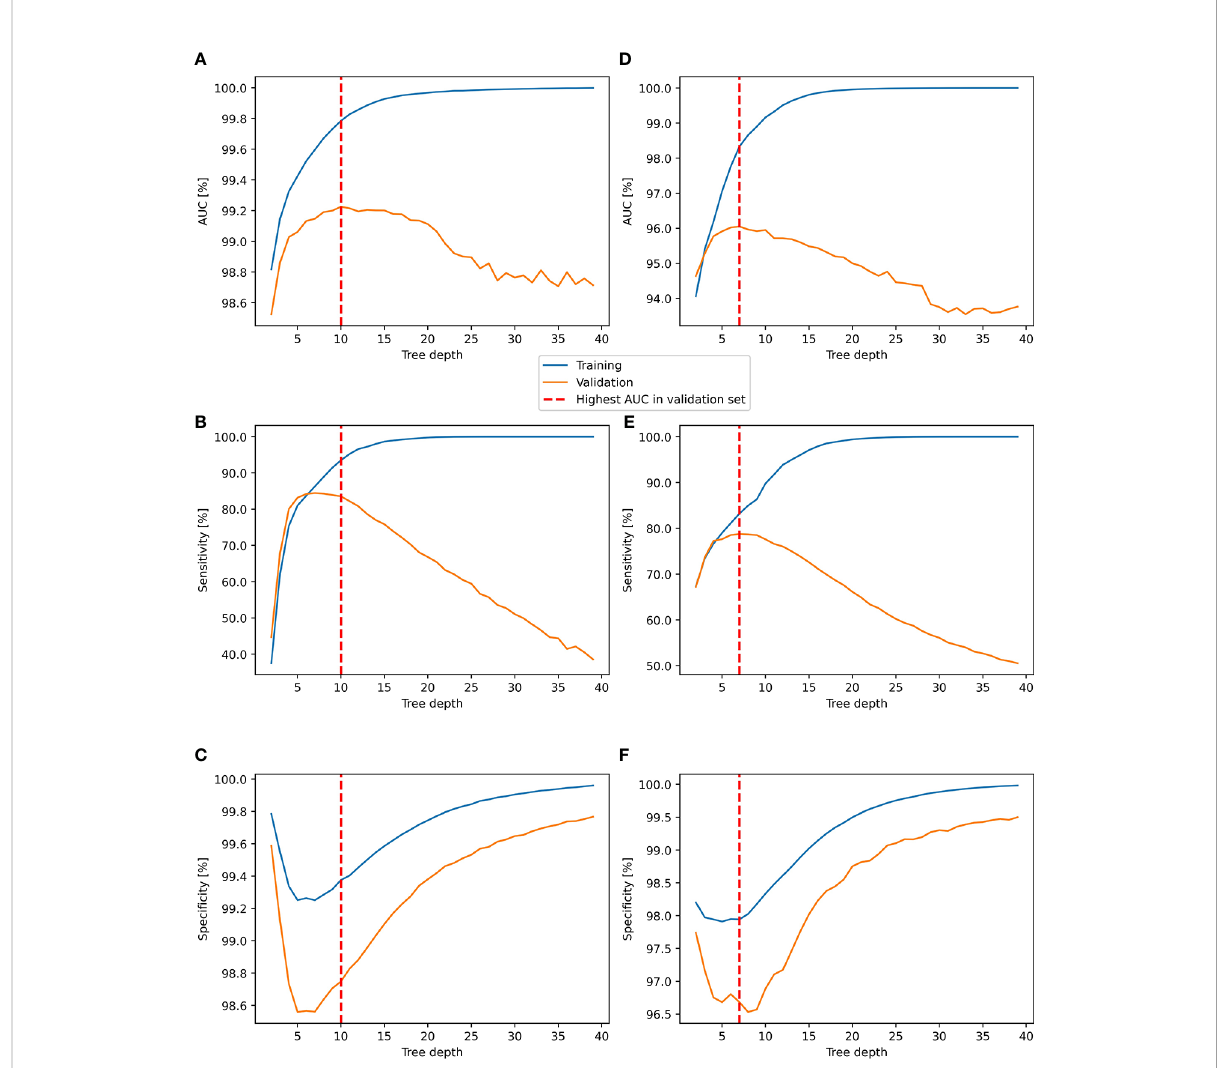
FIGURE 6 Performance of the RF classi fi er in the training and validation datasets for the classi fi cation of pulling hay (A – C) and all hay rack behaviors (D – F) . (A) AUC for pulling hay, (B) sensitivity of pulling hay, (C) speci fi city of pulling hay, (D) AUC for rack use, (E) sensitivity of rack use, and (F) speci fi city of rack use.